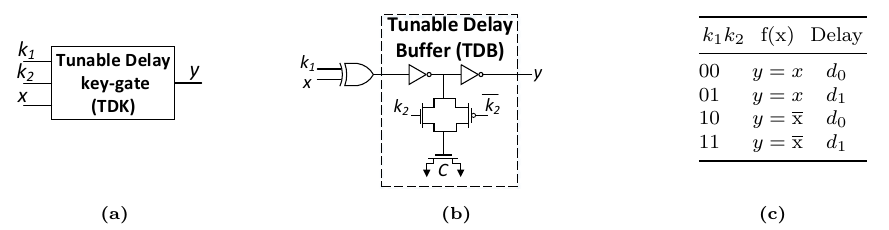
Figure 3: Overall Structure of Tunable Delay Key-Gate (TDK) used in Delay Logic Locking (DLL)[XS17]. (a) TDK Gate with Two Keys, one for Logic and one for Delay Locking. (b) Layout of TDK with a Tunable Delay Buffer (TDB), (c) Functionality and Delay of the